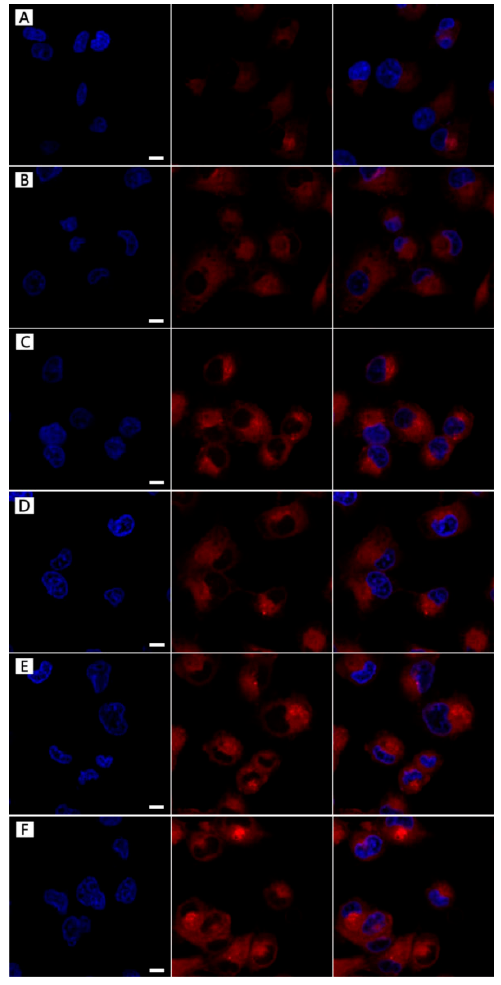
Figure 9. The localization of three kinds DOX loading LHNPs from CLSM: LHNPs@DOX ( A – D ), MLHNPs@DOX ( B – E ), FA-MLHNPs@DOX ( C – F ) in HeLa cells for 4 h ( A – C ) and 12 h ( D – F ). Bar: 1 μ m.